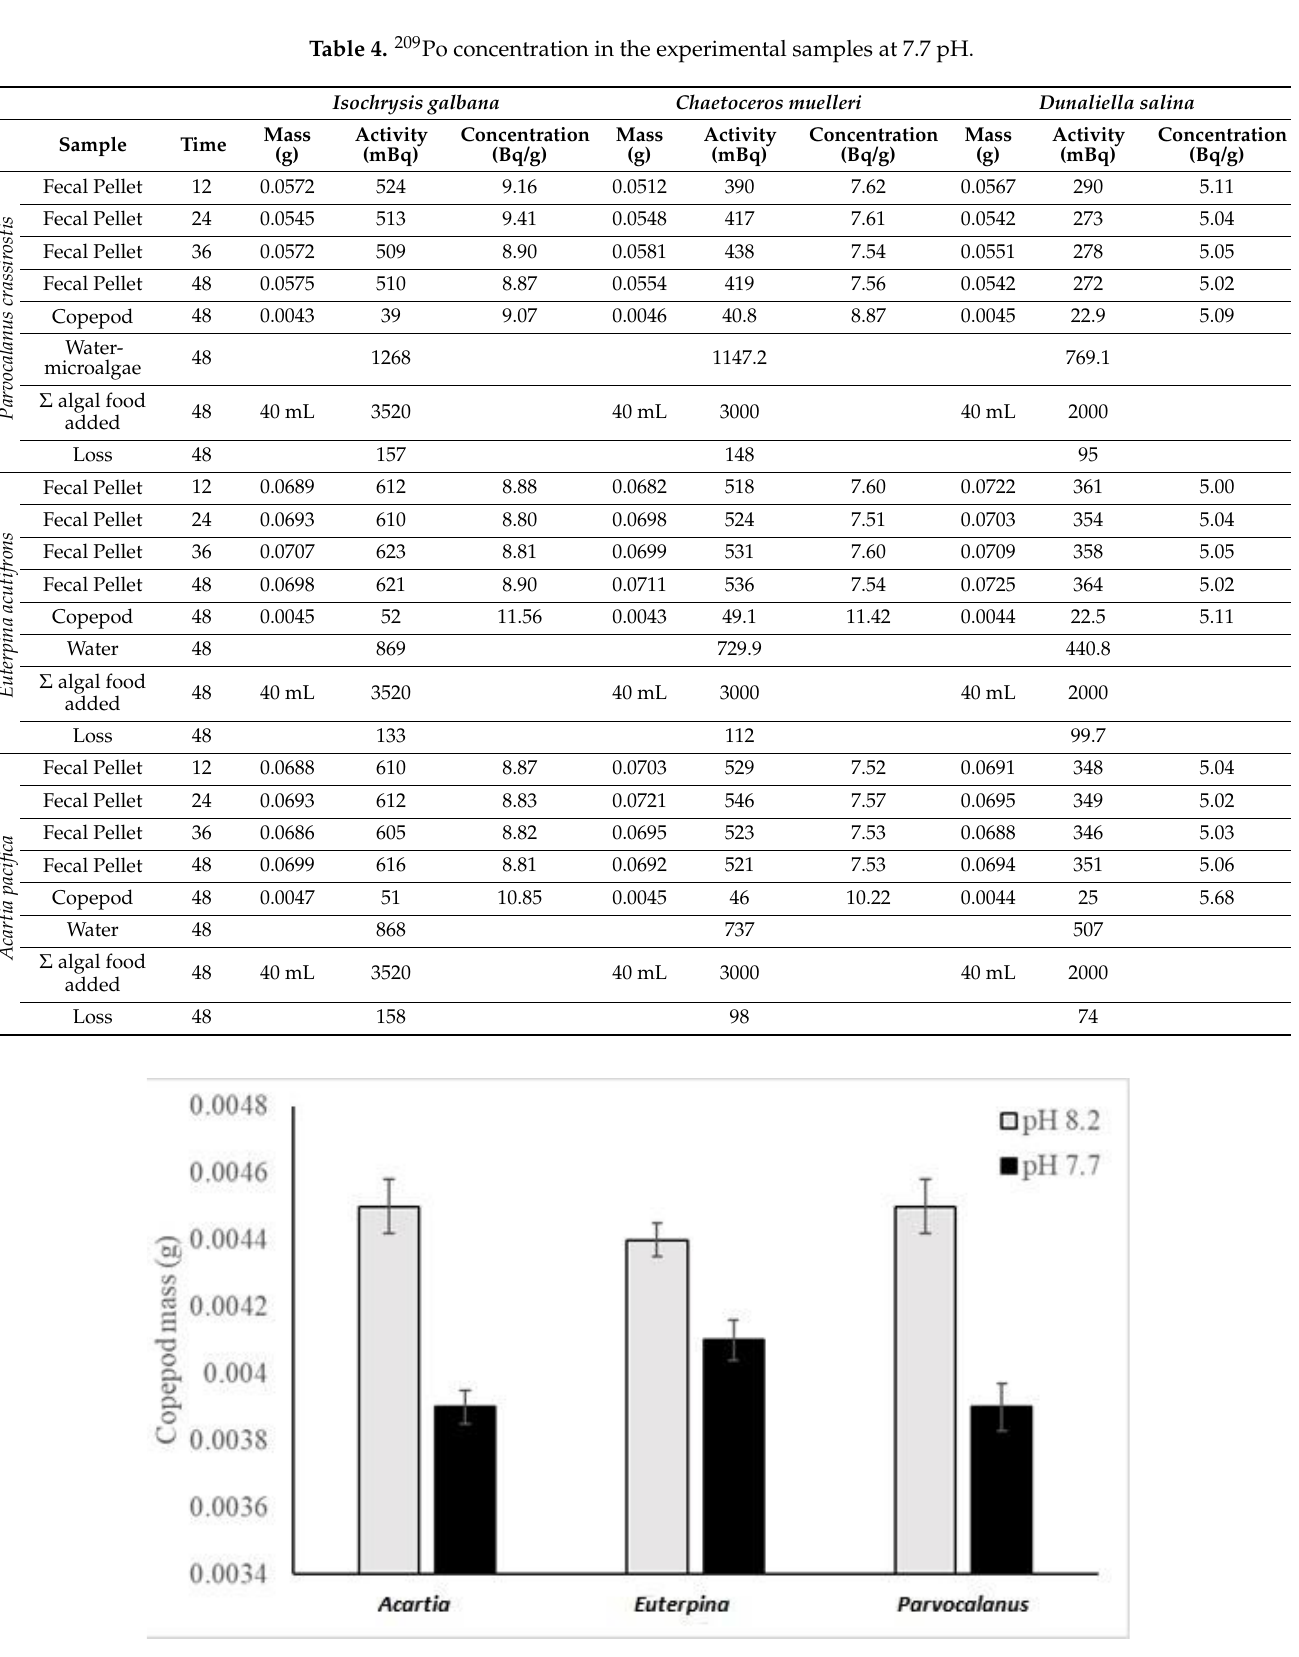
Figure 2. Copepod mass (in g) for the 3 copepod species ( Acartia pacifica , Euterpina acutifrons and Parvocalanus crassirostis ) and the two pHs (8.2 and 7.7). Results are presented as mean ± SEM.